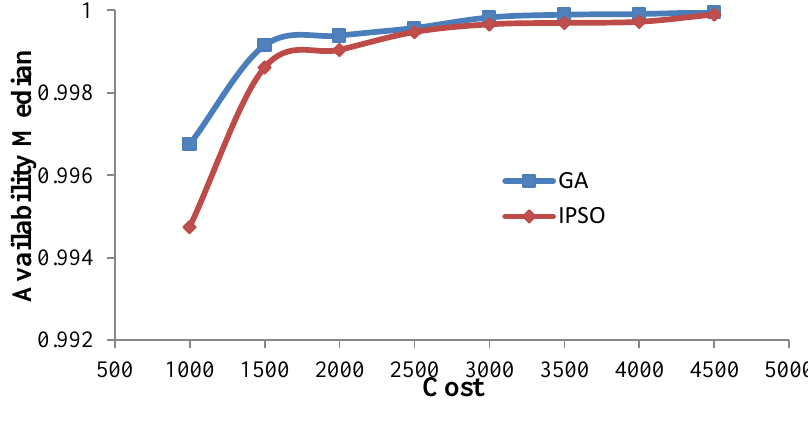
Fig. 6. Pareto front of results for GA and IPSO